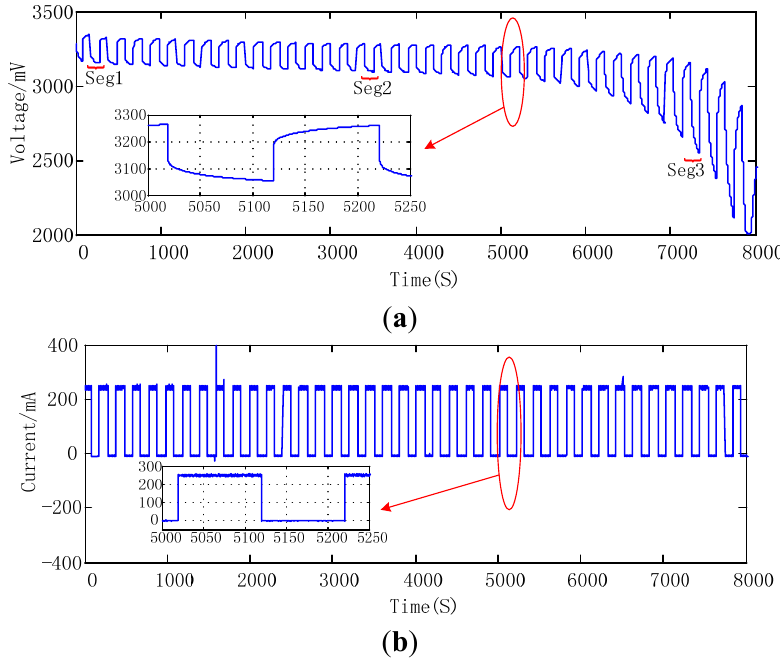
Figure 7. The discharge voltage and current: ( a ) Discharge voltage; ( b ) Discharge